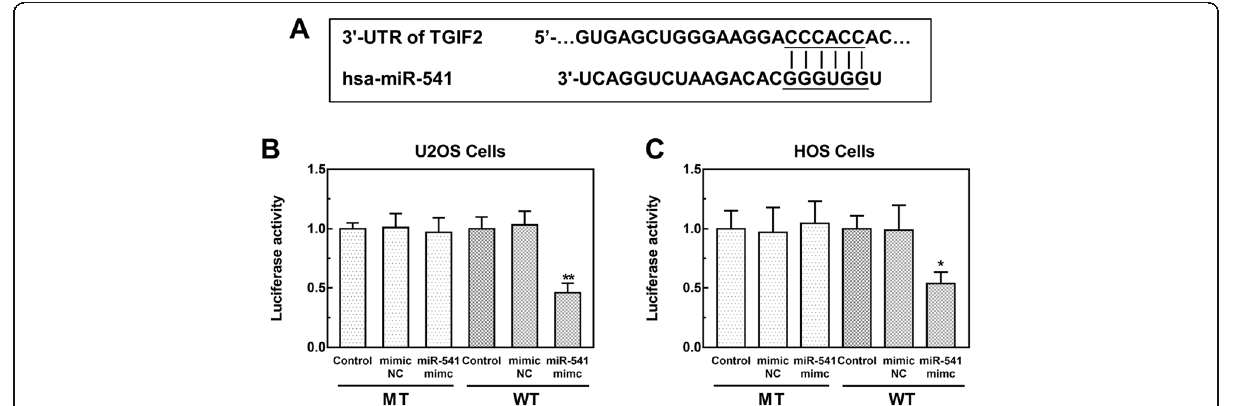
Fig. 5 TGIF2 is a potential target of miR-541. a Complementary sequences of miR-541 at the 3 ′ -UTR of TGIF2 . b and c Luciferase activity in U2OS and HOS cells (* P < 0.05, ** P <